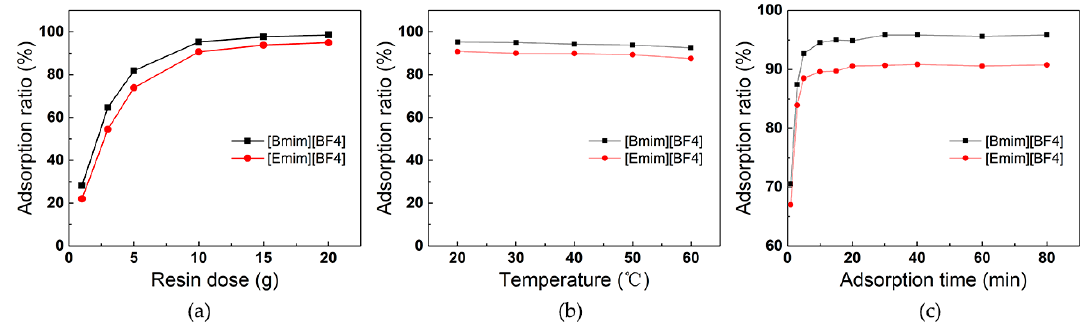
Figure 4. Effect of ( a ) resin dose; ( b ) temperature; ( c ) adsorption time on the adsorption ratio of ionic